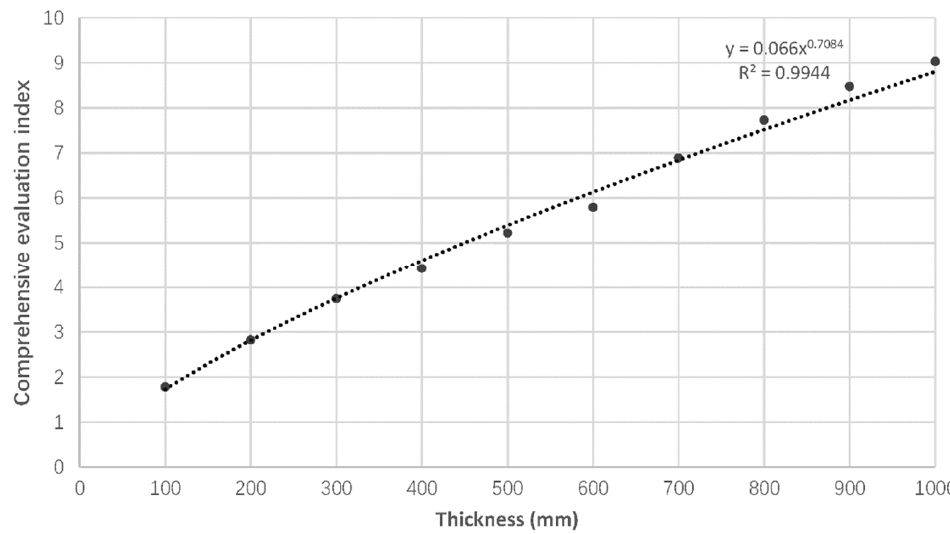
Figure 10. The relationship between thickness and M.